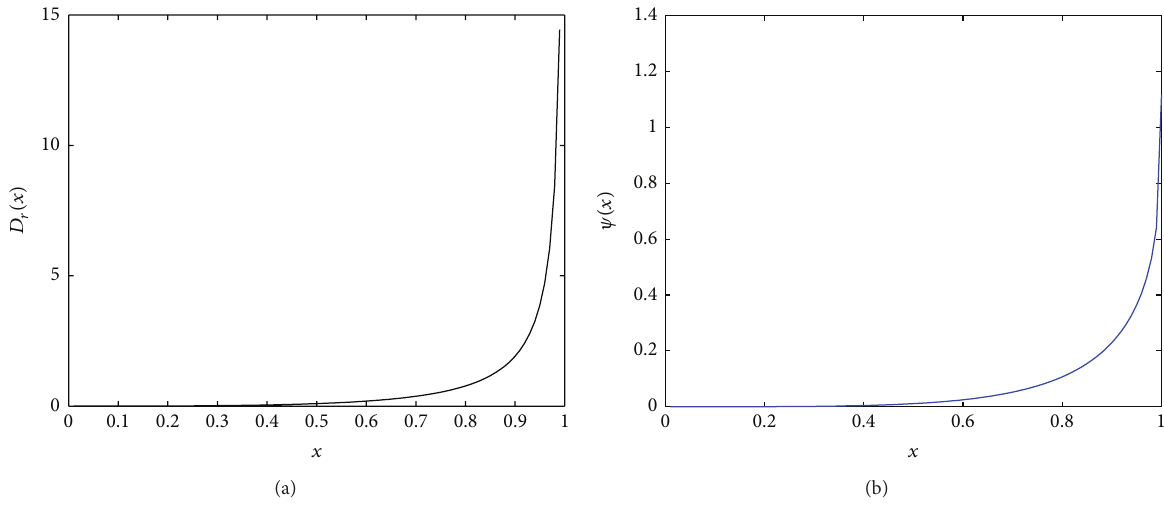
Figure 1: (a) 𝐷𝑟(𝑥) function. (b) 𝜓 ( 𝑥 )